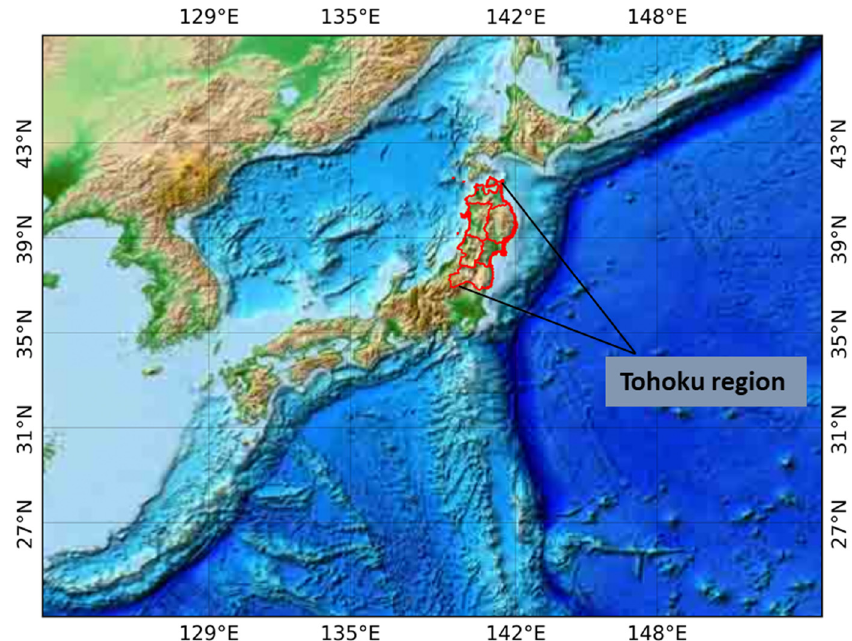
Figure 1. Location of the study area (Tohoku region of Japan) shown by red polygons over the topographic map.